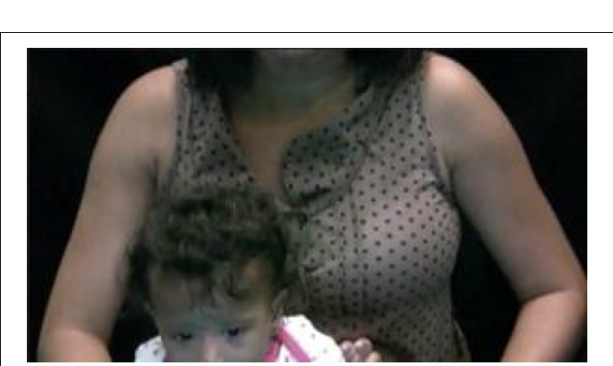
FIGURE 6 | Participant B (in-lab). Example of a 6-month-old infant that OpenFace may have trouble identifying all components due to the fact that the video did not capture all of the child’s face.